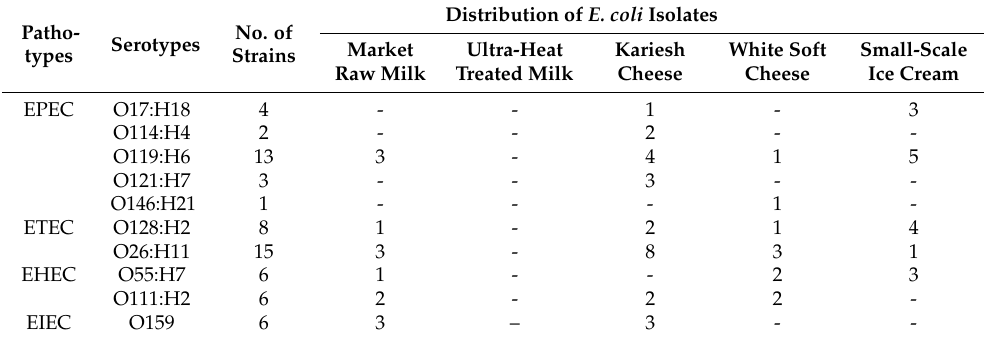
Table 3. Serological identification of E. coli isolated from milk and some dairy products.